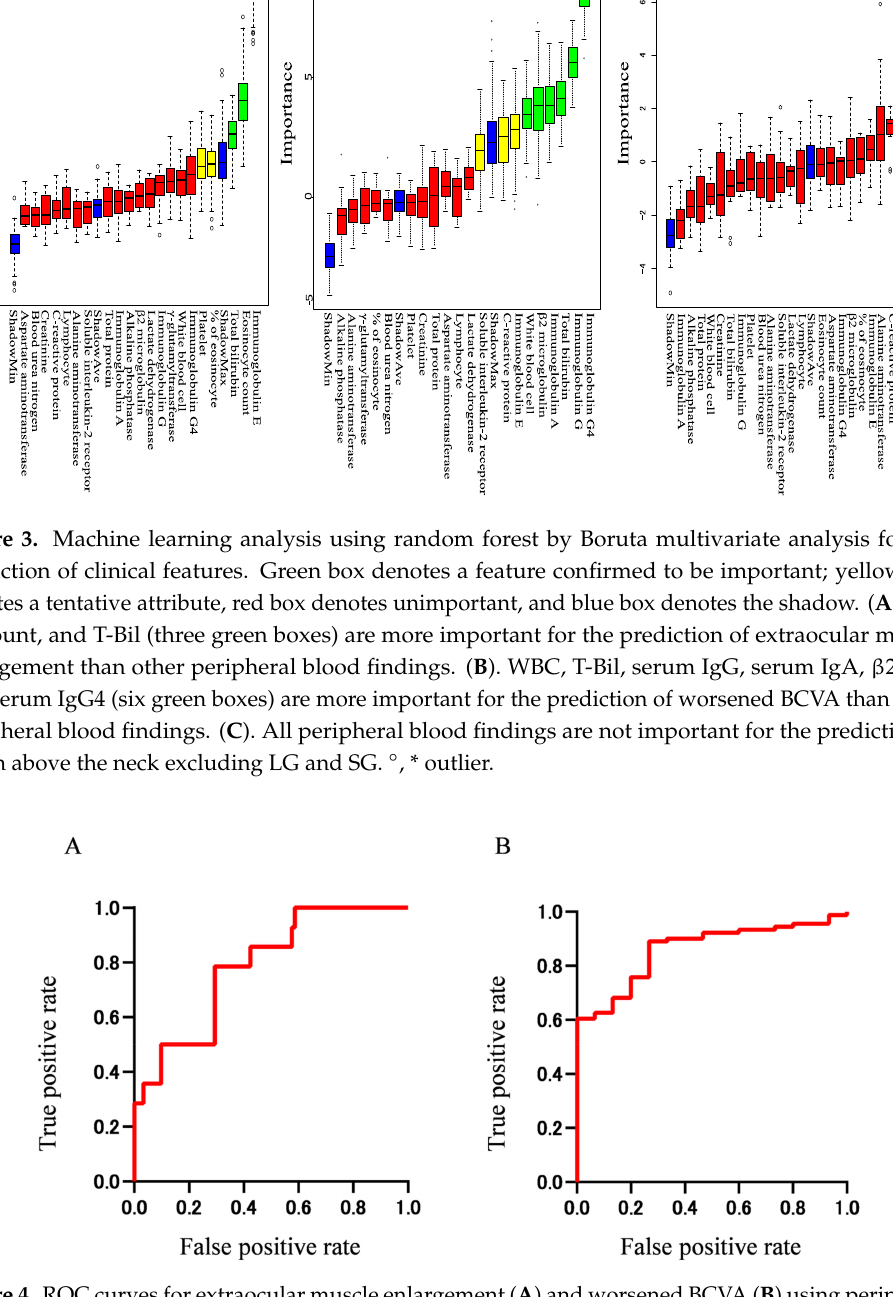
Figure 4. ROC curves for extraocular muscle enlargement ( A ) and worsened BCVA ( B ) using peripheral blood tests identified by Boruta multivariate analysis shown in Figure 3. A . AUC is 0.78 by ROC analysis using three green boxes in Figure 3B (IgE, number of Eo, and T-BIL). B . AUC is 0.86 by ROC analysis using six green boxes in Figure 3B (WBC, T-BIL, serum IgG, serum IgA, β 2-MG, and serum